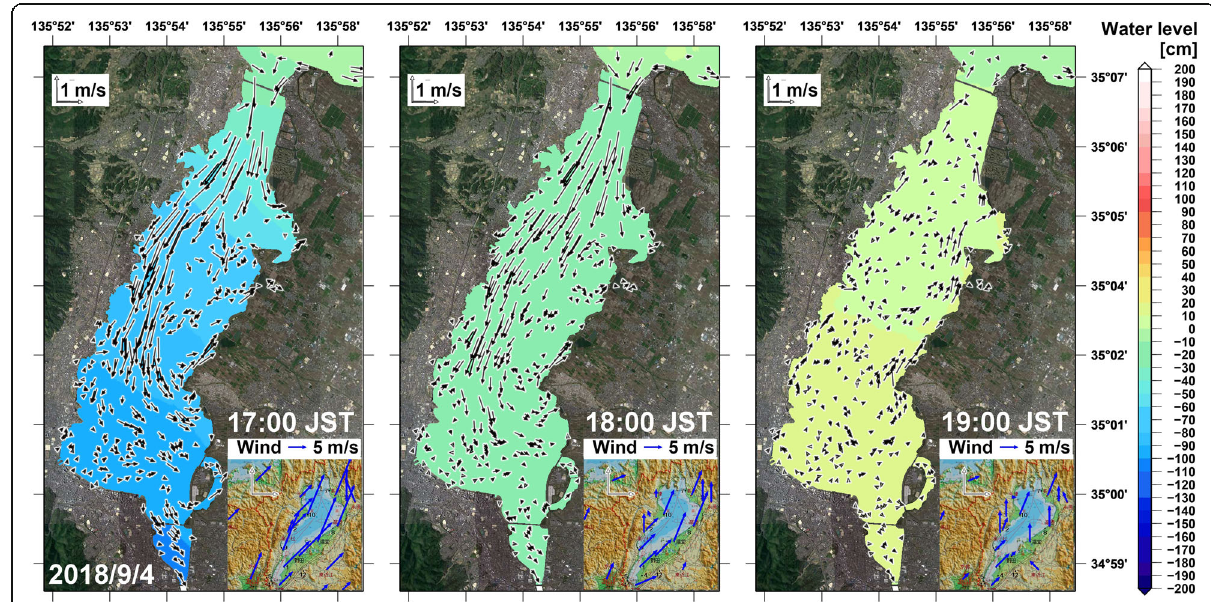
Fig. 11 The same data as in Fig. 10 but for the period when Typhoon 21 departed Lake Biwa (17:00 – 19:00